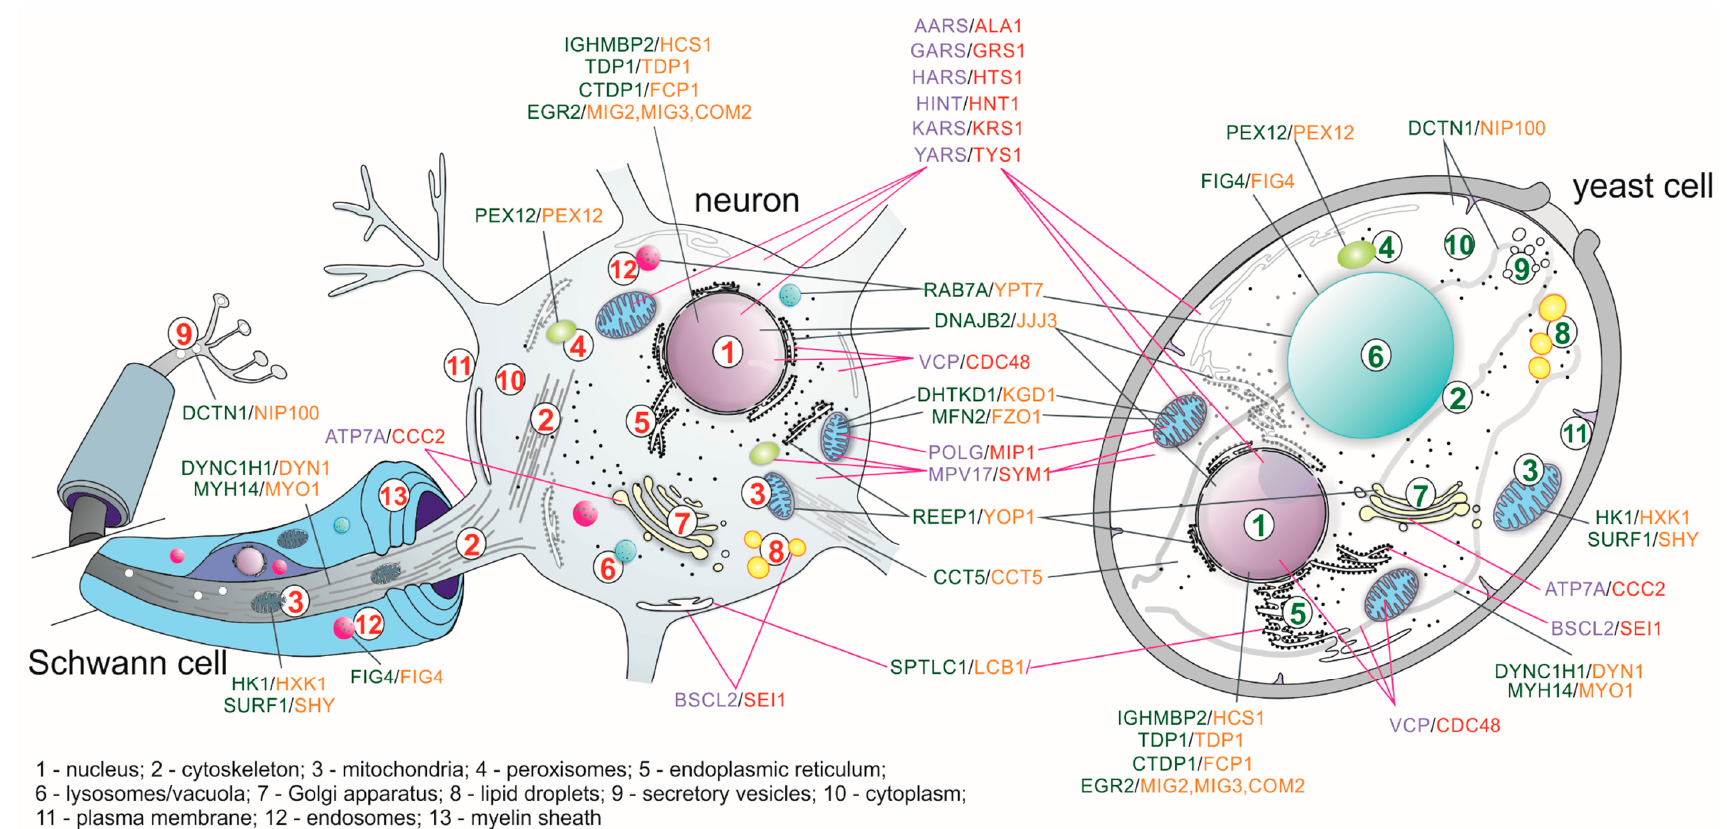
Figure 1. Scheme showing the localization of selected proteins, in which mutations have been associated with hereditary peripheral neuropathies in a human nerve cell and a yeast Saccharomyces cerevisiae cell. The violet color indicates human proteins complementing mutations in yeast proteins, marked in red; green indicates human proteins possessing orthologs in yeast S. cerevisiae that are marked orange.